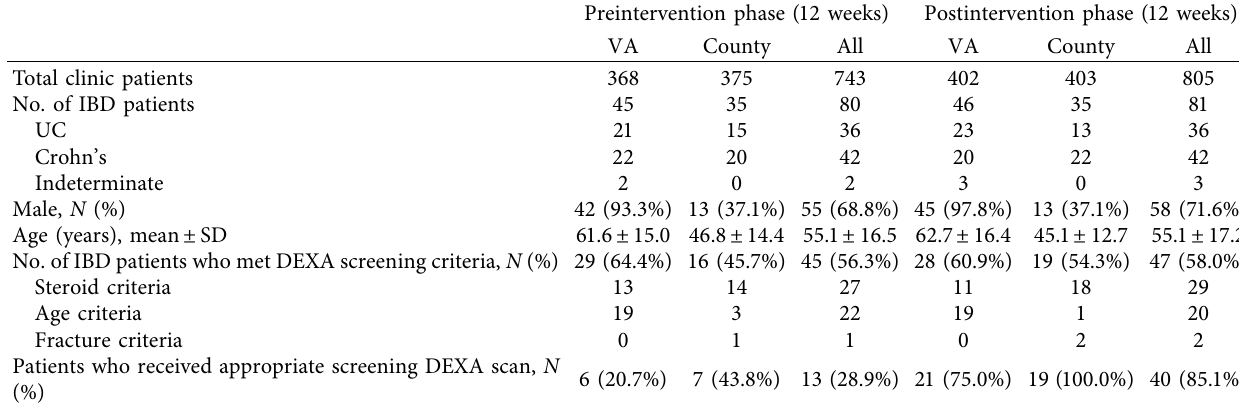
Table 1: Demographic data, characteristics, and DEXA screening rate for IBD patients who are at risk of osteoporosis. Preintervention phase (12